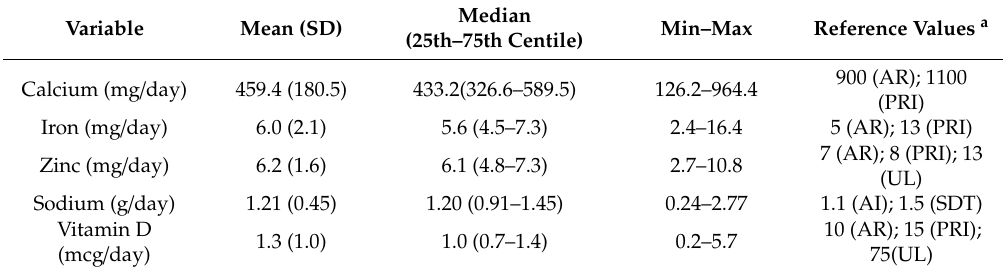
Table 11. Daily dietary intake of minerals and vitamin D in children aged 7 ≤ years < 11 ( n = 95) † .